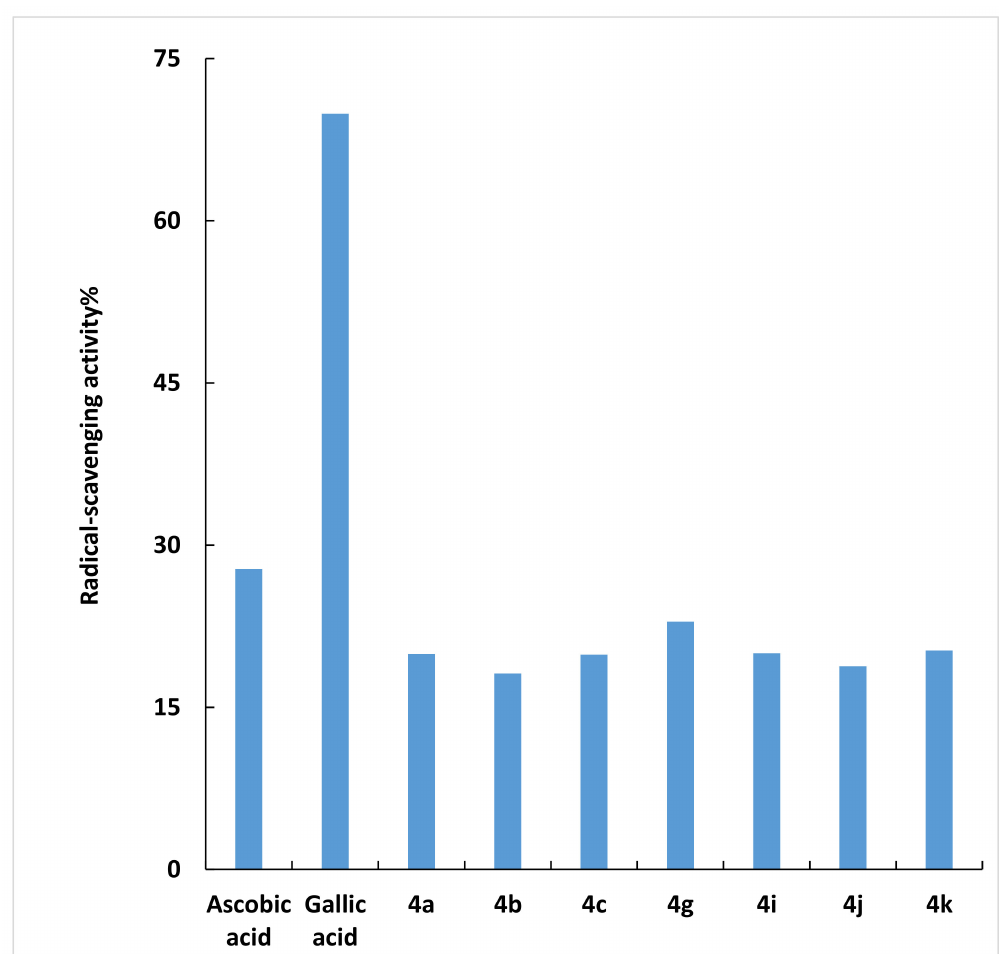
Figure 1. 2,2-diphenyl-1-picrylhydrazyl (DPPH) scavenging activity of 1 µ M of compounds 4a–4c , 4g , 4i–4k , ascorbic acid and gallic